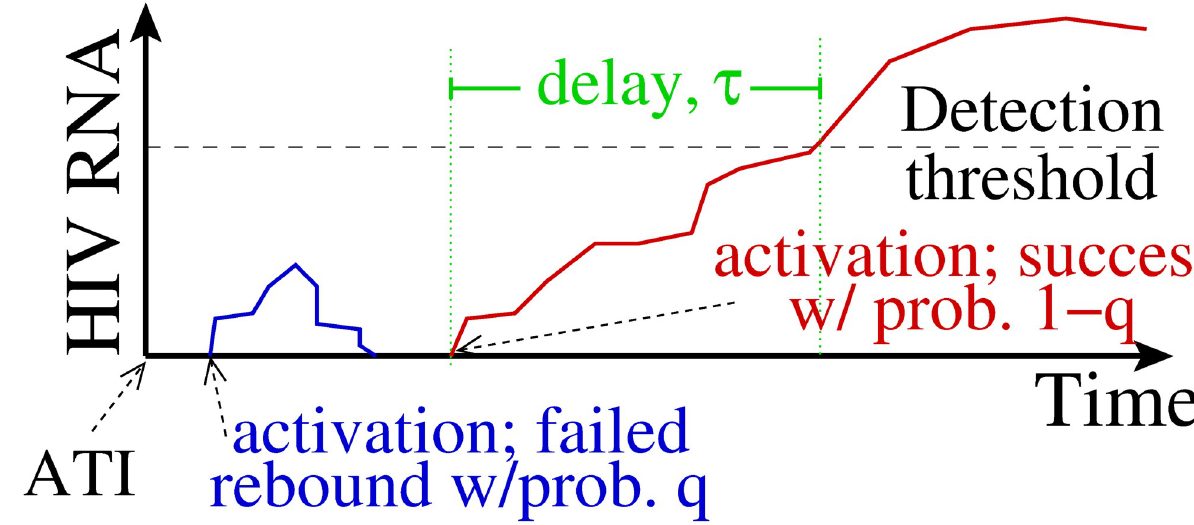
Fig 2. Model schematic. We assume that following ATI, latent cell activations are followed by chains of infection that may die out, i.e., go extinct, with probability q , or successfully re-establish high viral loads associated with chronic infection, with probability 1 − q . In the latter case, we further assume a delay τ between activation and the time when plasma viral load crosses the detection threshold.